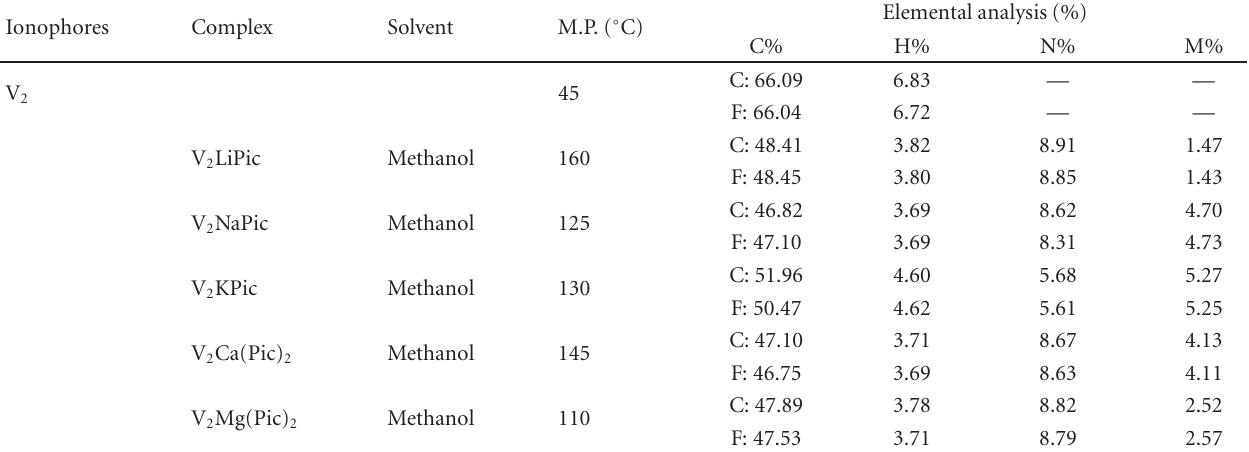
Table 1: Properties of isolated complexes of alkali and alkaline earth metal salts with anthraquinone-derived ionophore V 2 . Ionophores Complex Solvent